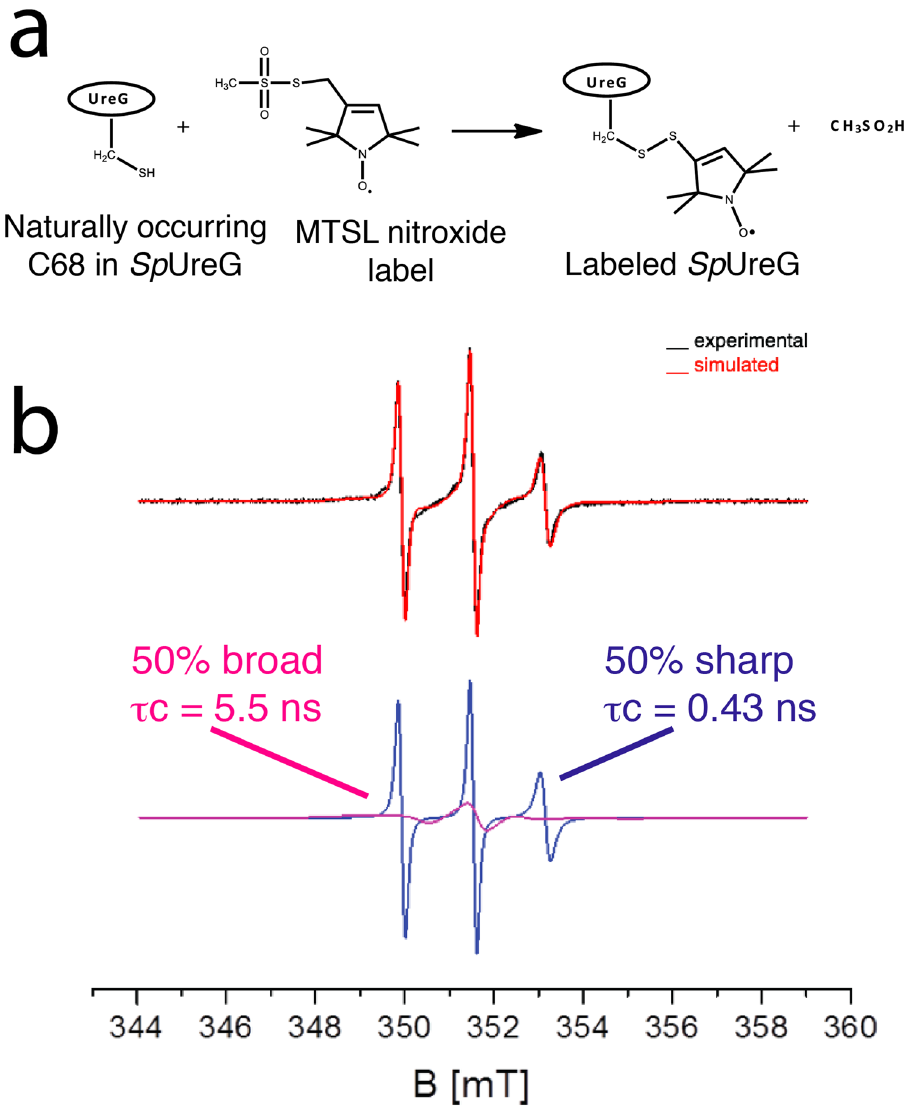
spin label. ( b ) Top panel : SDSL-EPR spectrum of Sp UreG-MTSL under native conditions in 20 mM TrisHCl pH 8, 150 mM NaCl (black) and the corresponding spectrum (red) simulated using SimLabel program 32 . Bottom panel : Decomposition of the simulated spectrum into one sharp and one broad component. The corresponding correlation time ( τ c ) is indicated, together with the relative proportions of different